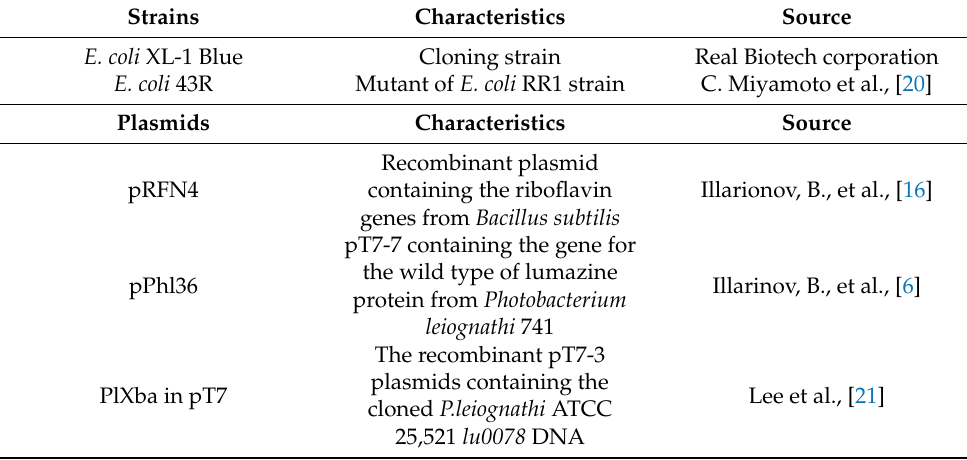
Table 1. Bacterial strains and plasmids used in this study. Strains Characteristics Source E. coli XL-1 Blue Cloning strain Real Biotech corporation E. coli 43R Mutant of E. coli RR1 strain C. Miyamoto et al., [20] Plasmids Characteristics Source Recombinant plasmid pRFN4 containing the riboflavin genes from Bacillus subtilis